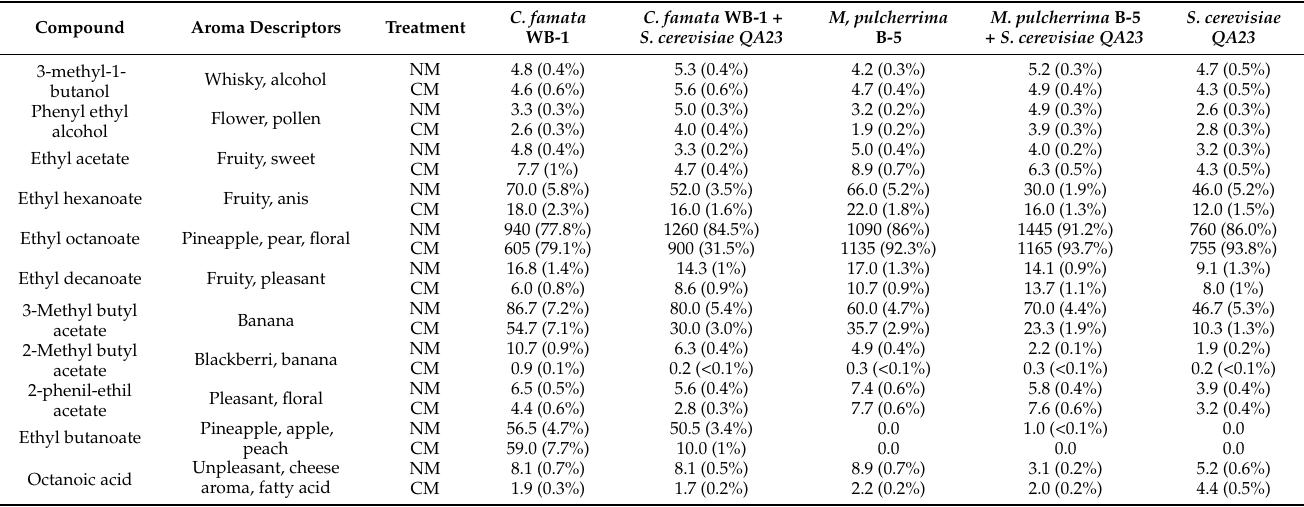
Table 3. Odour activity values (OAVs) and relative odour contribution (ROC) for the aroma com- pounds in analysed wines produced with and without